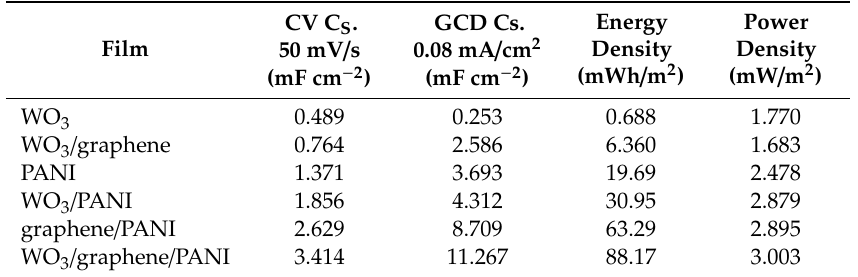
Table 1. Summary of capacitance, energy density, and power density values of the di ff erent films calculated for cyclic voltammogram (CV) and galvanostatic charge-discharge (GCD) results (Calculation methods shown in supporting